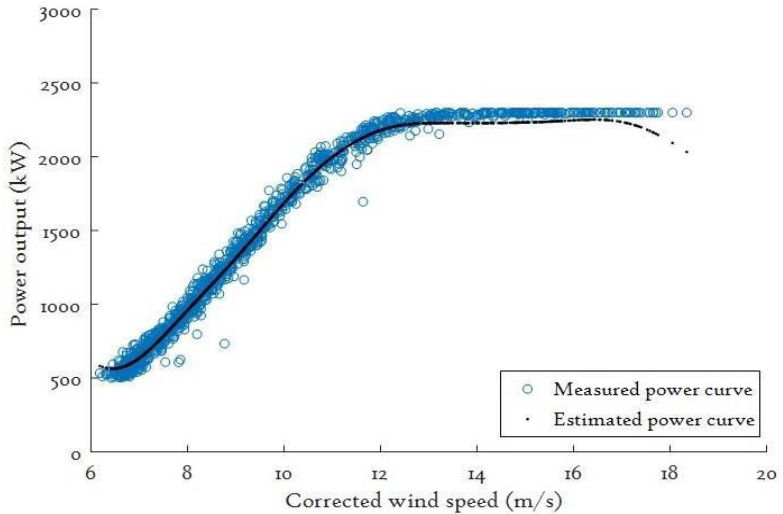
Figure 4. Estimated power curve and measured data.